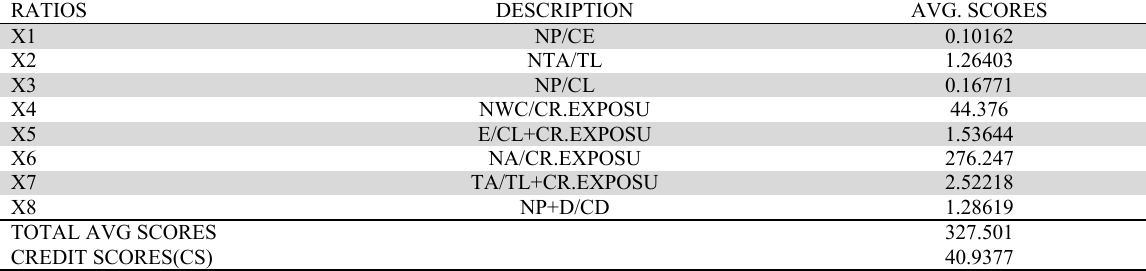
Risk Description Model – Ratio